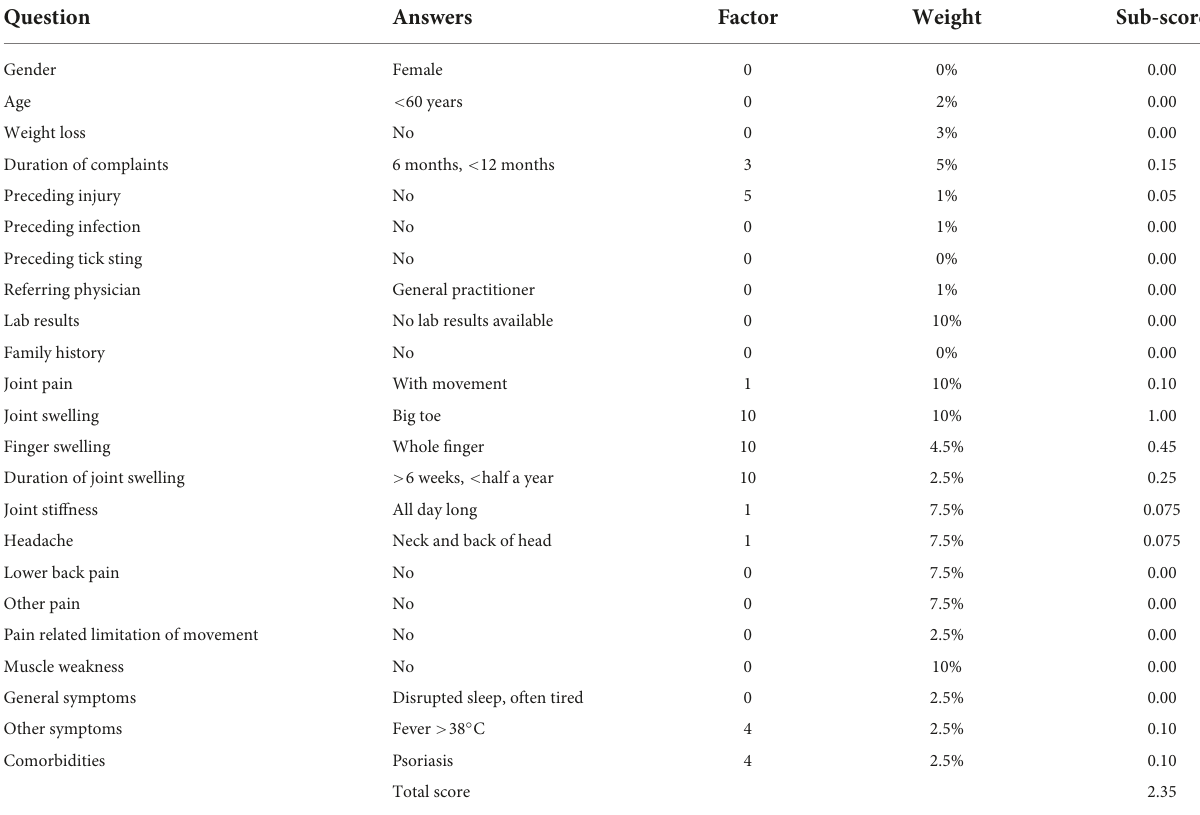
TABLE 1 Example of a questionnaire summary report including the respective score calculation.